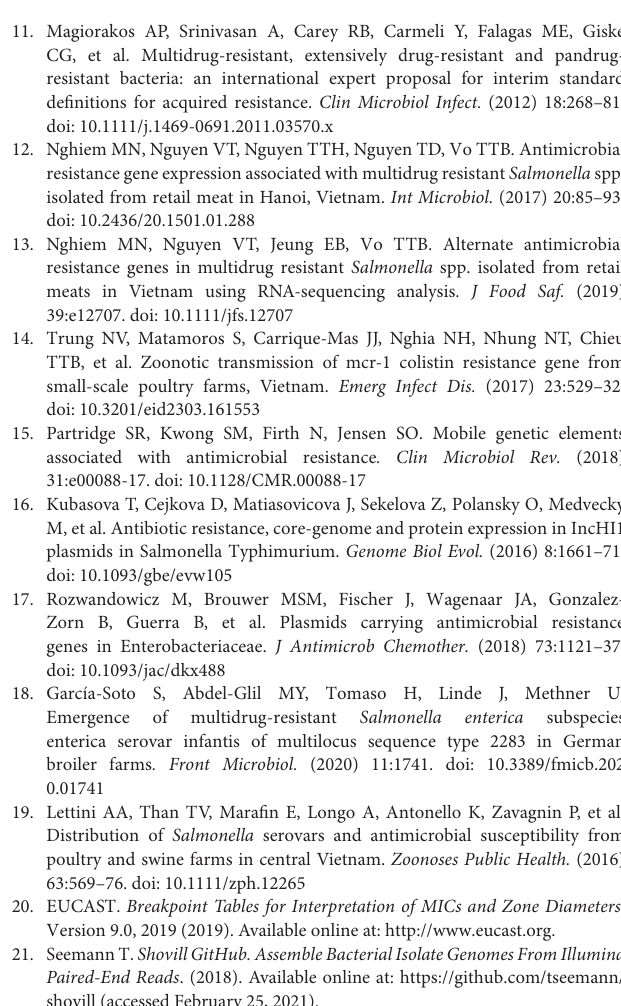
Supplementary Table 3 | Single-nucleotide polymorphism (SNP) analysis. Supplementary Table 4 | IncHI1 plasmid isolates’ identity percentage comparison. Supplementary Table 5 | Genome accession number